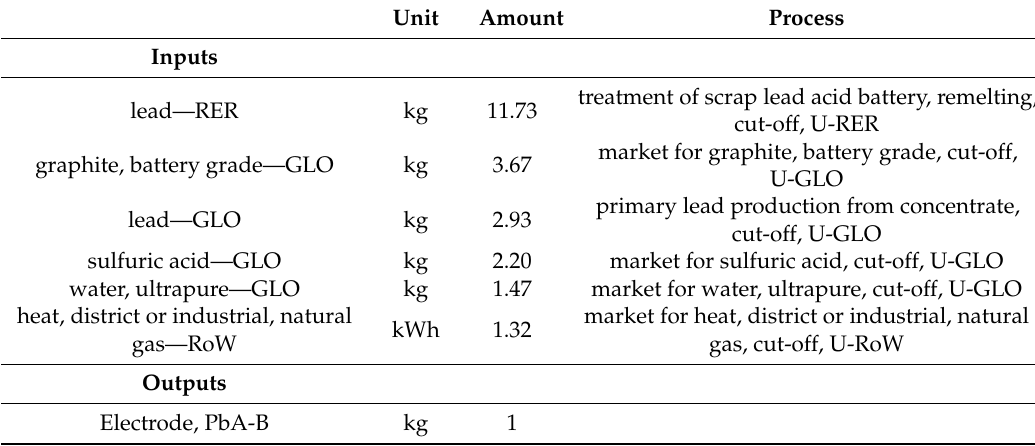
Table A16. Manufacturing Electrode,